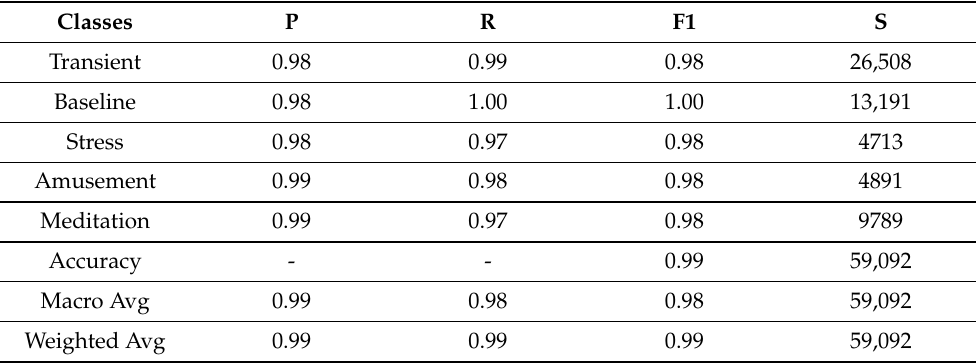
Table 1. Proposed model result of Client 1 for round 1. Key: Precision-P; Recall-R; F1-score-F1; S-Support.